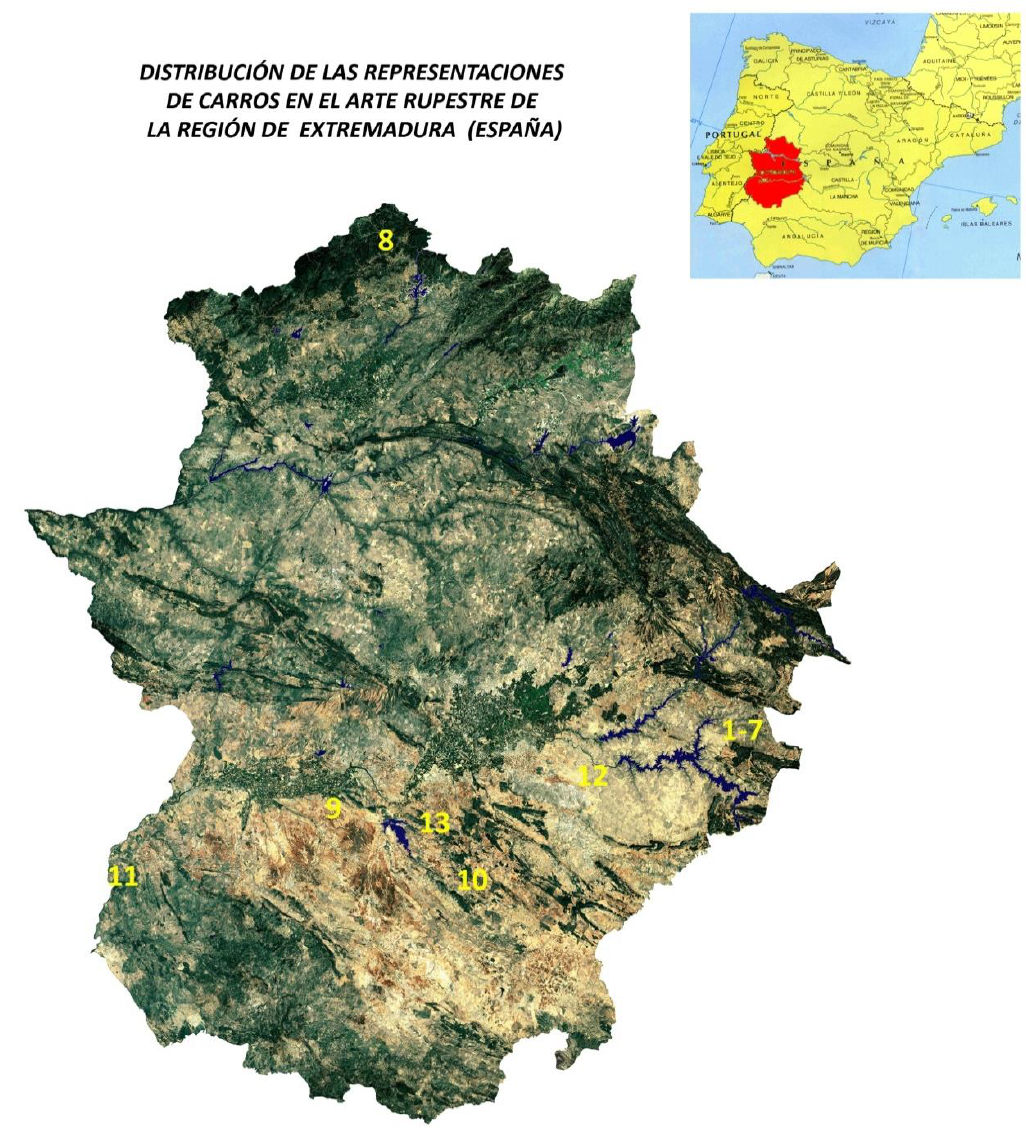
Figure 7. Distribution of “chariots” figures in Extremadura rock